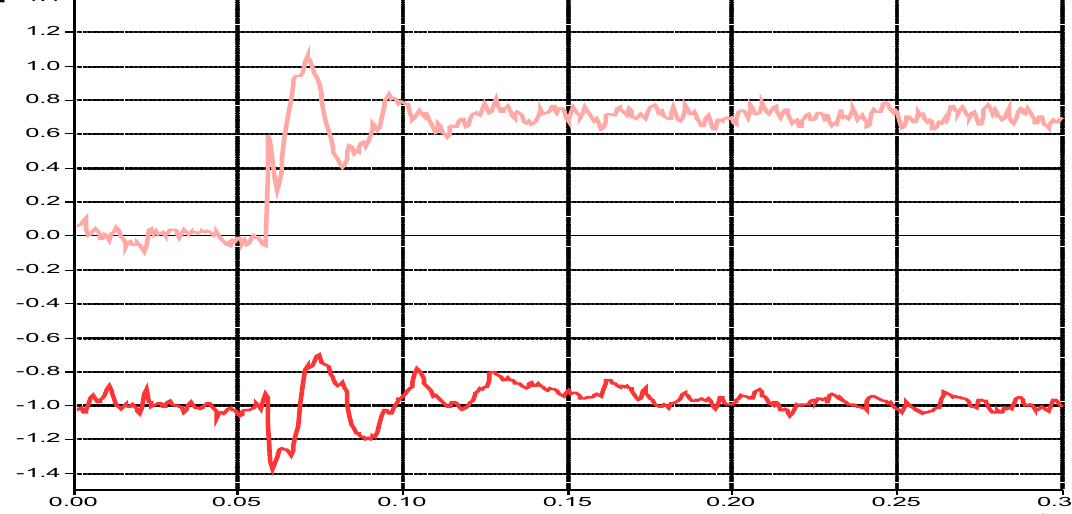
Figure 24. Current in direct axis and quadrature axis I grid .